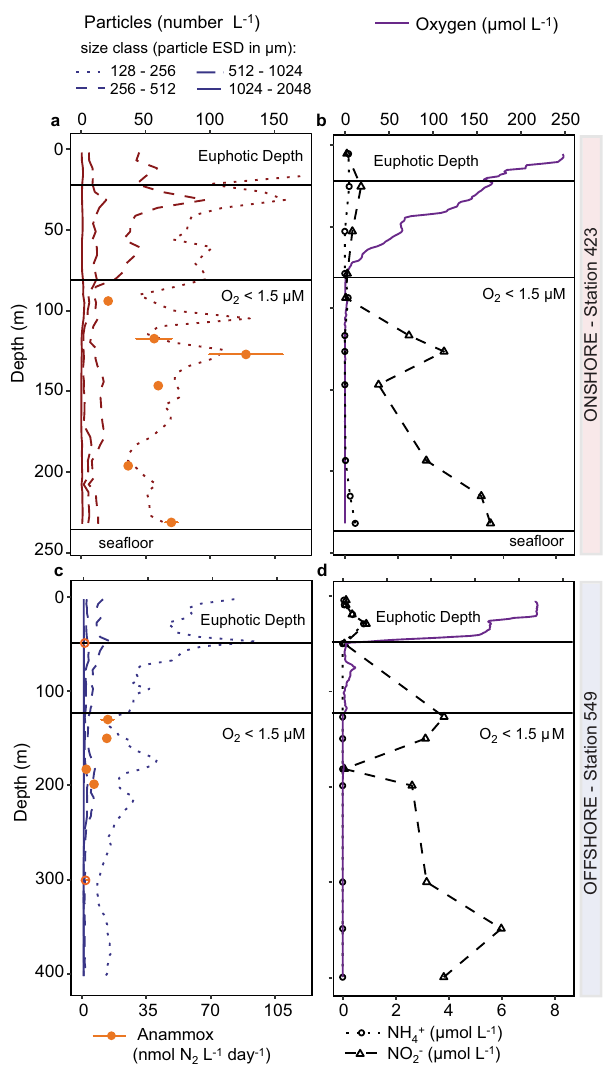
Fig. 1 Physico-chemical parameters, particle abundance and anammox rates from an exemplary onshore and offshore station in the Peruvian upwelling system in April 2017. In situ particle abundances and anammox rates from a onshore station 423 (total water depth 241 m) and c offshore station 549 (total water depth 4350 m). b and d Depth pro fi les of oxygen (purple line), ammonium (open circles) and nitrite (open triangles) concentrations. Particles were sorted into four size classes with equivalent spherical diameters (ESD) of 128 – 256, 256 – 512, 512 – 1024, and 1024 – 2048 µ m. Particle abundances in the smallest size class reached up to 398 particles L − 1 in the upper 20 m of the onshore station. Anammox rates were determined in time series incubations at six discrete depths. Signi fi cant rates are shown with closed circles, rates that are not signi fi cantly different from zero are shown with open circles (see Supplementary Table 1). Error bars represent the standard error of the slope. The base of the euphotic zone (where photosynthetically active radiation (PAR) dropped to <1%, based on Aqua-MODIS satellite data) and the oxic – anoxic interface (where O 2 dropped to <1.5 µ M) are indicated. euphotic zone at the onshore stations (up to 3.6 ± 2.8 mm 3 L − 1 ) and towards the centre of the euphotic zone at the offshore sta- tions (up to 3.2 ± 2.4 mm 3 L − 1 ), after which they declined to minima of 0.5 mm 3 L − 1 in both the onshore and offshore OMZ (Fig. 2, Supplementary Figs. 1 and 2a and b). At some shallow onshore stations, particle and aggregate volume increased again